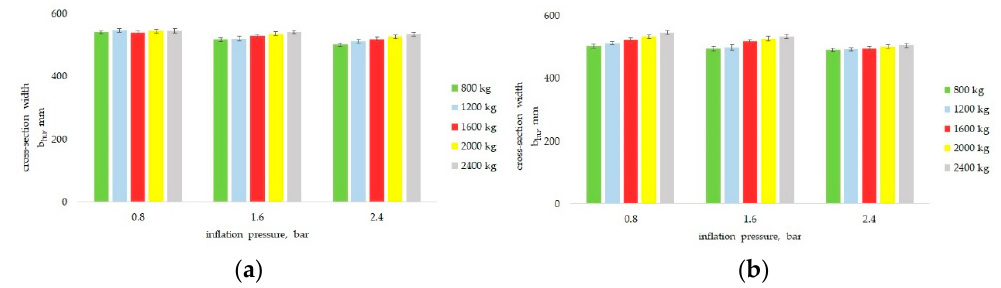
Figure 8. The values of width of cross-sections: radial tire ( a ); bias-ply tire ( b ).